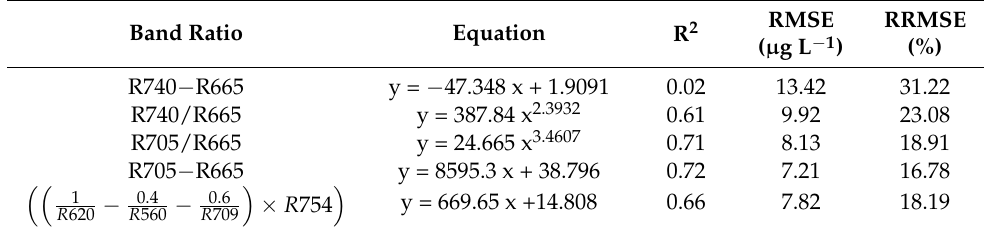
Figure 5. ( a ) Validation of R705/R665 algorithm (the dotted line is 1:1 line) and ( b ) R705/R665 algorithm recalculated with all the data. Table 6. Validations